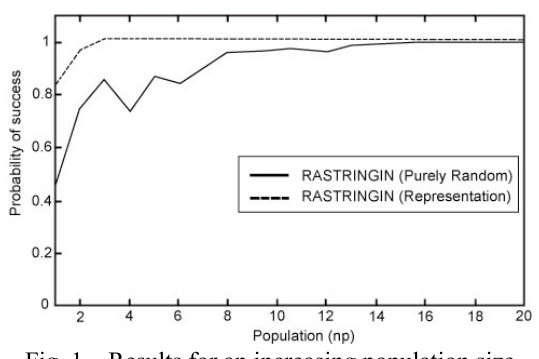
Fig. 1 – Results for an increasing population size (Rastringin’s function)